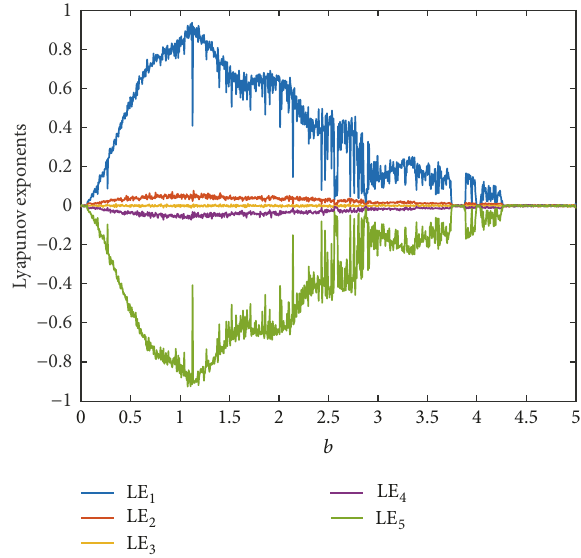
Figure 2: The dependence of finite-time local LEs of the system (2) on parameter 𝑏 , with 𝑎 = 1